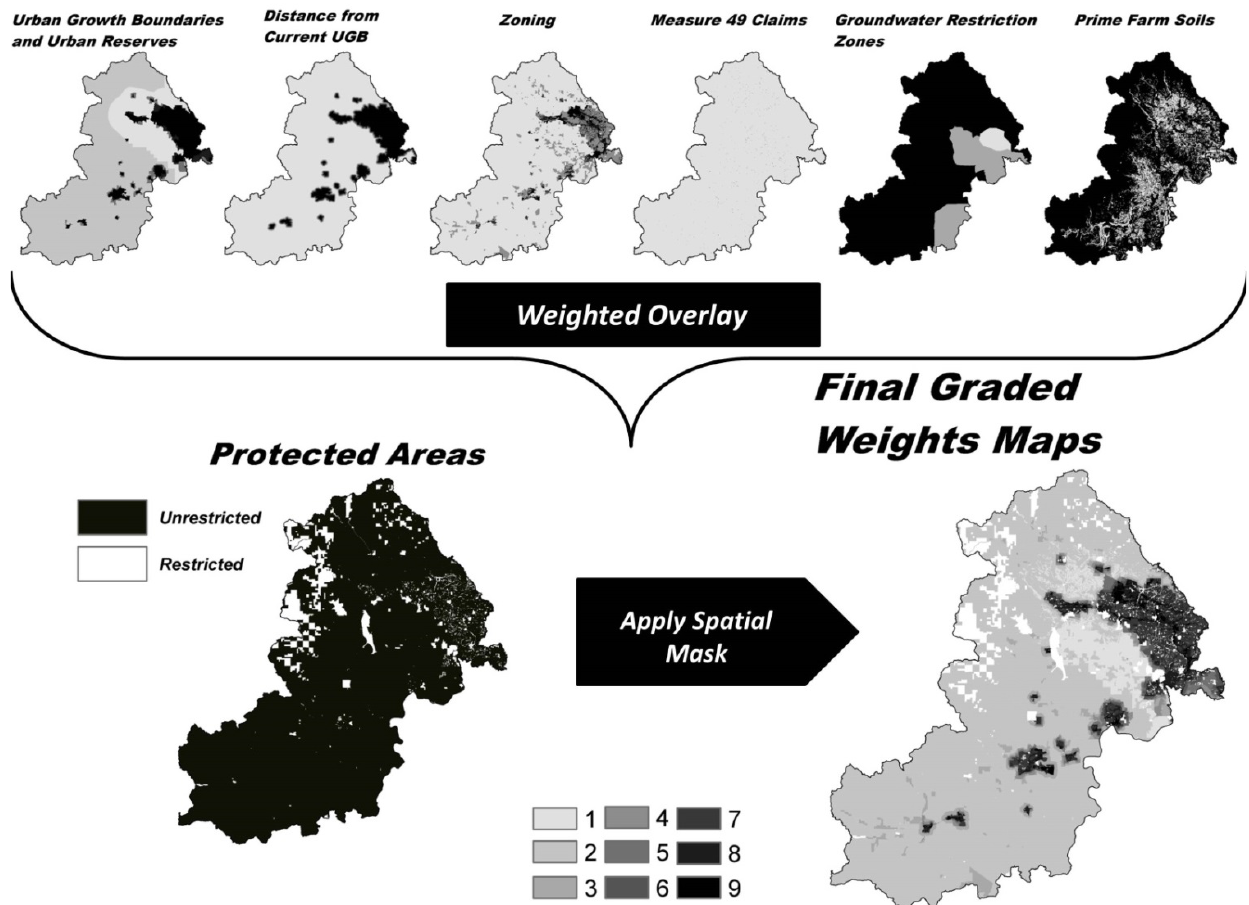
Figure 4. Maps of the six criteria (urban growth boundaries, distance from current urban growth boundaries, zoning, groundwater restriction zones, high value farm soils and Measure 49 claims) used to construct the graded weights